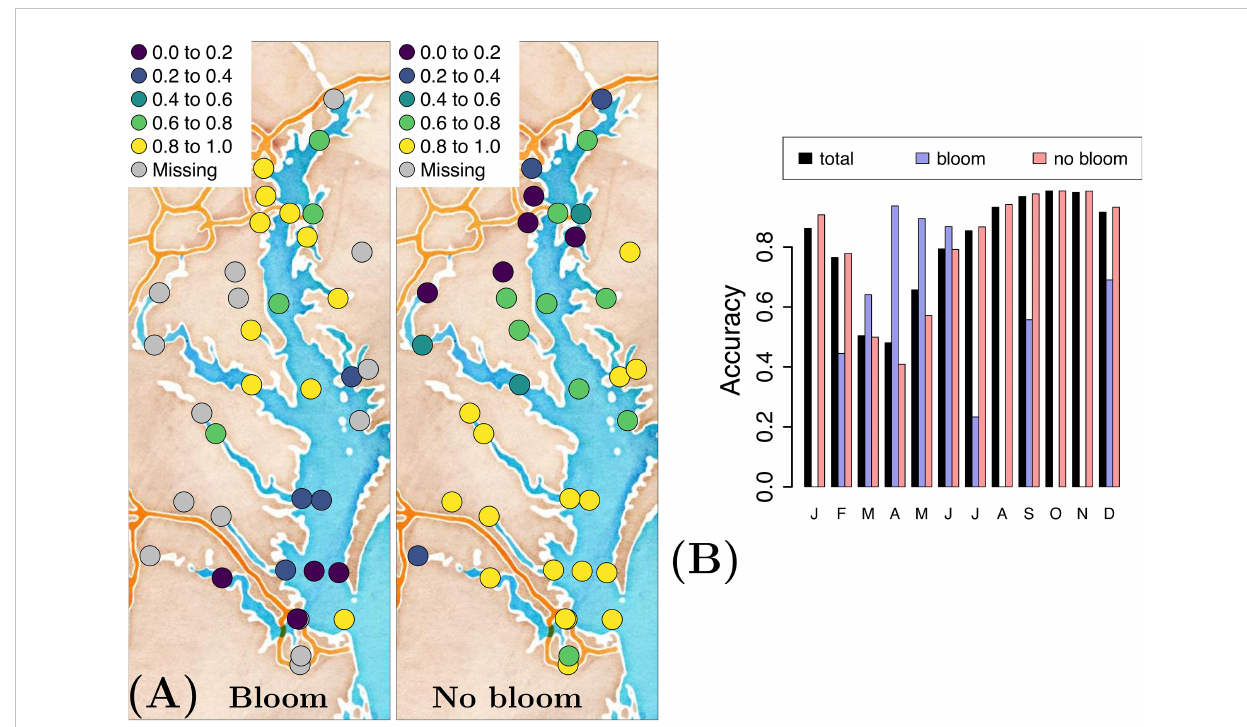
FIGURE 3 (A) Accuracy of forecasting a P. minimum bloom and no-bloom occurrence, and (B) the corresponding temporal distribution of the accuracy when using the optimal variable combination {T, S, pH, swrad, TON} and applying a generalized linear